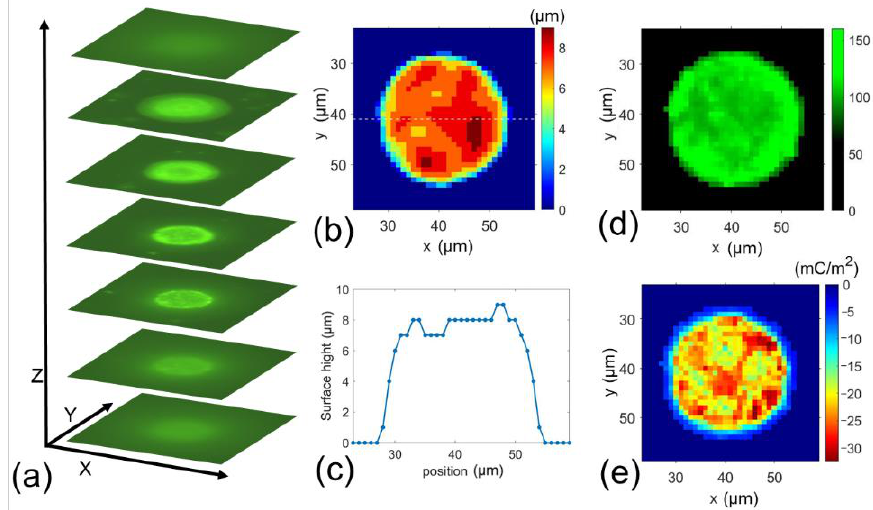
Figure 6. Typical measurement results of surface charge mapping of a HUVEC cell. ( a ) Z-stack images, ( b ) surface height mapping, ( c ) the surface height profile at the centerline of the cell along X-direction, ( d ) fluorescent intensity distribution, and ( e ) cell surface charge mapping.